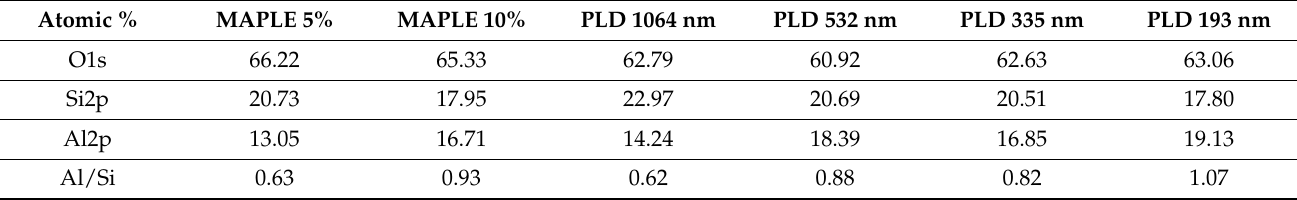
Table 5. Films atomic composition and Al/Si